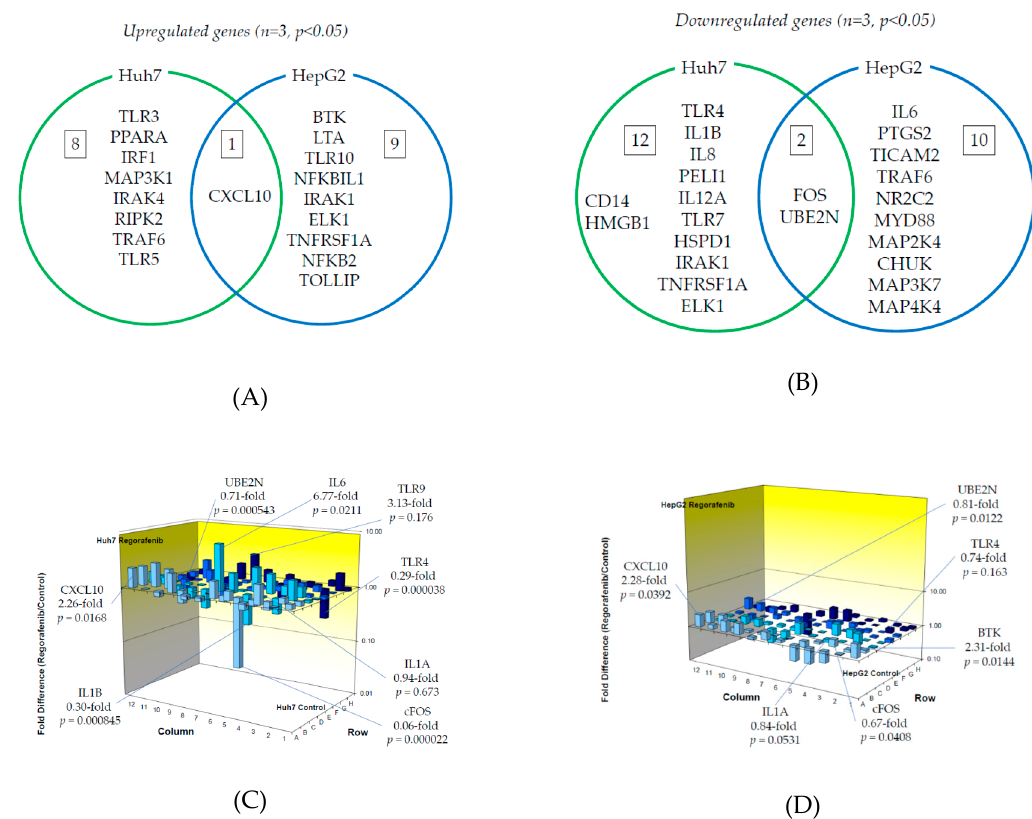
Figure 3. Effects of regorafenib treatment on Toll-like receptor (TLR)-related gene expression in human hepatoma Huh7 and HepG2 cells: ( A ) Upregulated genes ( p < 0.05); ( B ) Downregulated genes ( p < 0.05); ( C ) Changes of TLR-related gene expression in Huh7 cells treated with or without regorafenib; ( D ) Changes of TLR-related gene expression in HepG2 cells treated with or without regorafenib. Cells were treated with or without 2 µ M regorafenib for 24 h and cellular RNA was extracted. Eighty-four TLR-related genes were evaluated by real-time PCR-based array ( n = 3). p -values, compared to those of untreated cells.